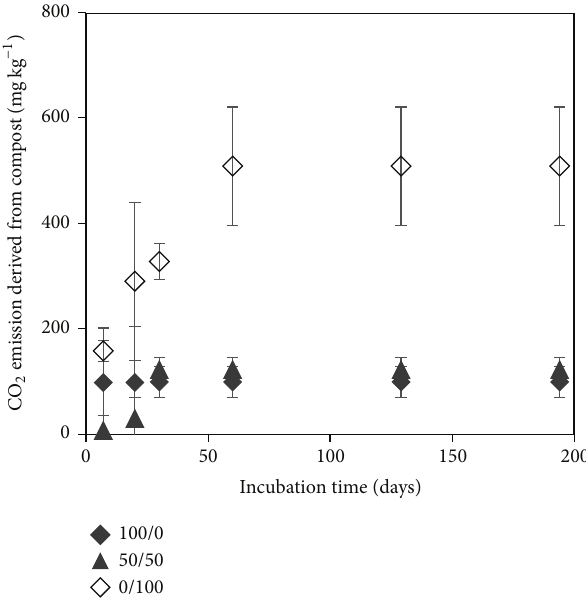
Figure 2: Cumulative CO 2 emission derived from AMC with inorganic/organic = 100/0, 50/50, and 0/100. Vertical bars indicate the standard error.